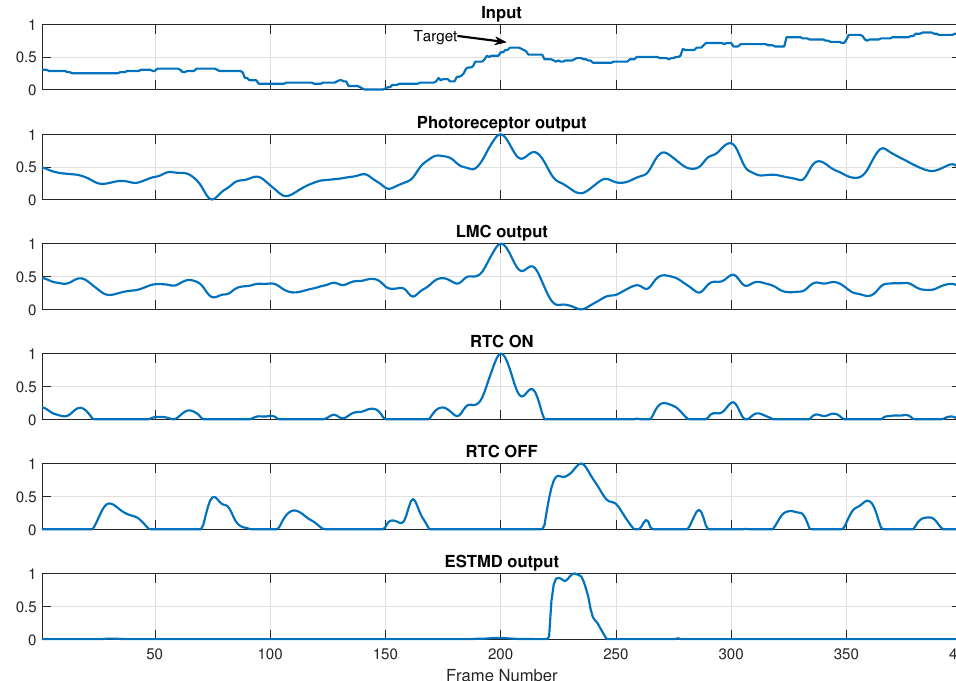
Figure 4. Temporal profiles of the normalized responses of the BIV stages to the input target pixel shown in Figure 1c. The multistage processing of the BIV has significantly increased the temporal contrast of the